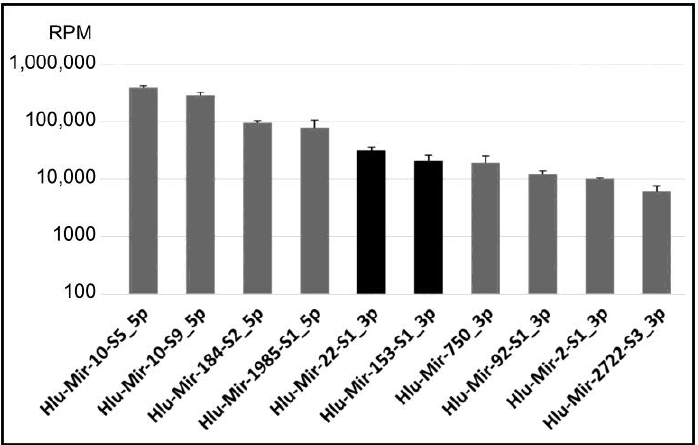
Figure 1. The expression levels of the top 10 most abundant miRNAs in H. lucorum CNS. The data shown are mean ± SD normalized in reads per million (RPM). The expression levels of remaining miRNAs are presented in Supplementary File S2.